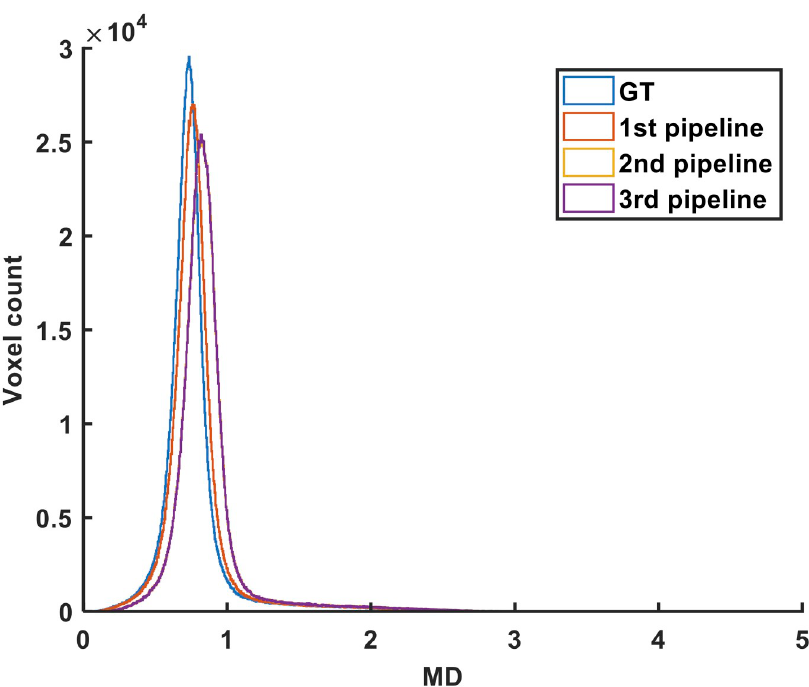
Fig 7. Distribution of the MD values in the WM region generated by the three pipelines after processing of the ground-truth data.